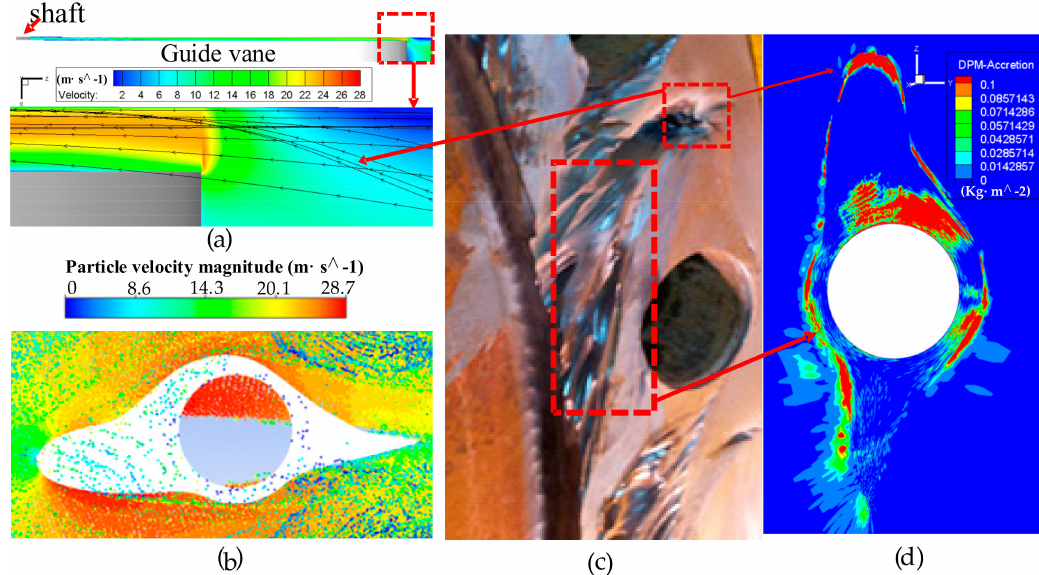
Figure 11. Comparison of wear morphology and flow field on the end-surface of the head cover: ( a ) Flow field at the leading edge of guide vane airfoil (XZ section); ( b ) particle velocity in the clearance; ( c ) wear morphology; and ( d ) DPM